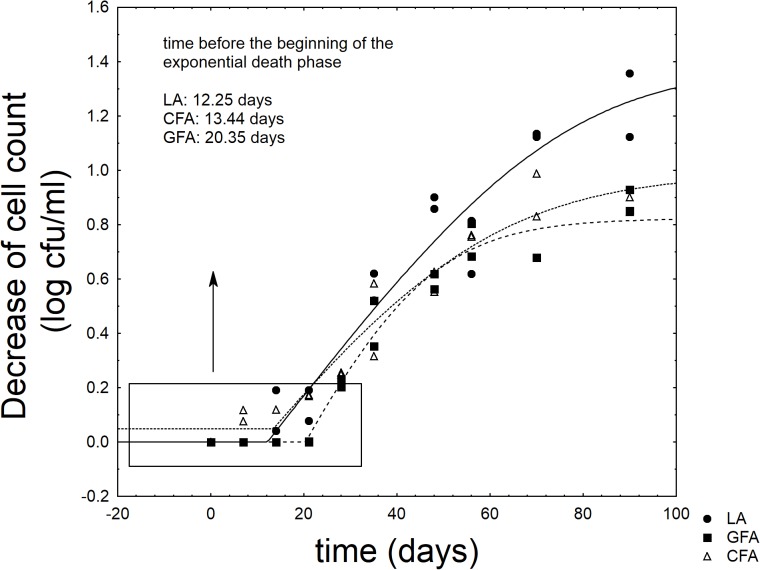
Decrease of cell count of L. acidophilus in the fermented milk. LA, product with L. acidophilus; GFA, product with L. acidophilus and Gluten Friendly flour; and CFA, product with L. acidophilus and control flour. The line represents the best fit through the lag-exponential model.